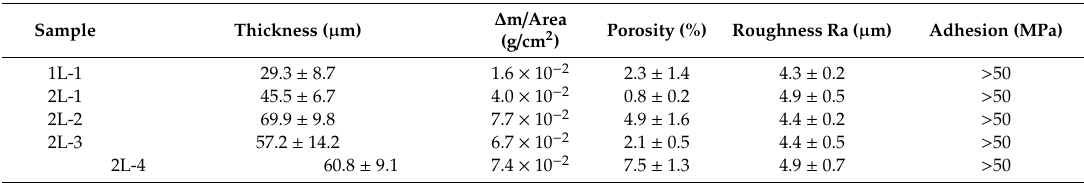
Table 2. Morphological features of the di ff erent coatings